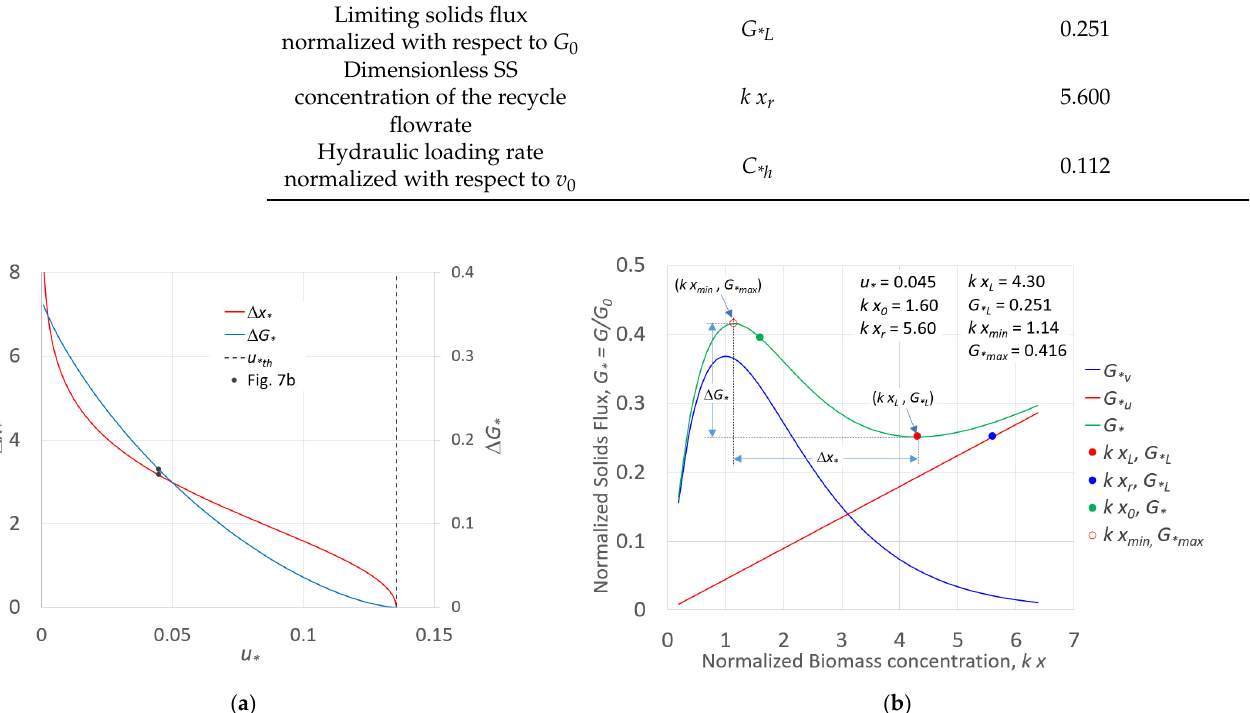
Table 2. Dimensional parameters and their symbols and values, corresponding to the application of Figure 7b.